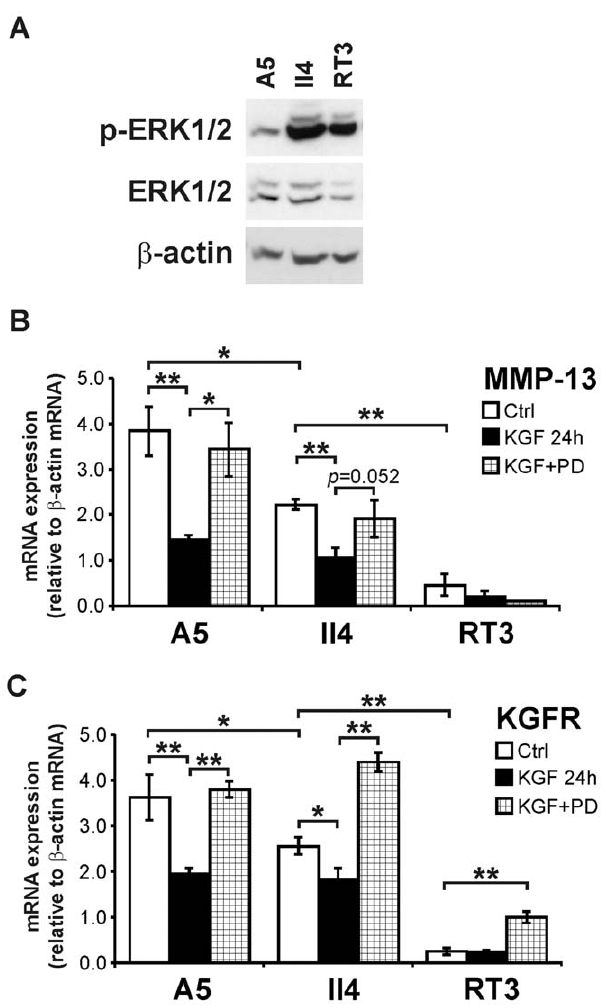
Figure 7. KGF downregulates MMP-13 and KGFR expression in Ha- ras -transformed HaCaT cells via ERK1/2. Three Ha- ras -trans- formed HaCaT cell-derived lines (A5, II4, and RT3) were used. A5 is benign tumorigenic cell line, II4 forms invasive malignant tumors, and RT3 cells form metastatic SCCs in vivo . ( A ) A5, II4, and RT3 cultures were serum-starved overnight and the cell lysates were analyzed for phosphorylated ERK1/2 (p-ERK1/2) and total ERK1/2 by western blotting. b -actin was determined as loading control. ( B, C ) Serum- starved A5, II4, and RT3 cells were pre-treated with PD98059 (30 m M) for 1 h and KGF (10 ng/ml) was added. After 24 h, total RNA was extracted and analyzed for MMP-13 mRNA ( B ) and KGFR mRNA ( C ) using qPCR. The amplification results were normalized for b -actin mRNA levels in each sample. * p , 0.05, ** p , 0.005, with independent samples T-test, n=3.